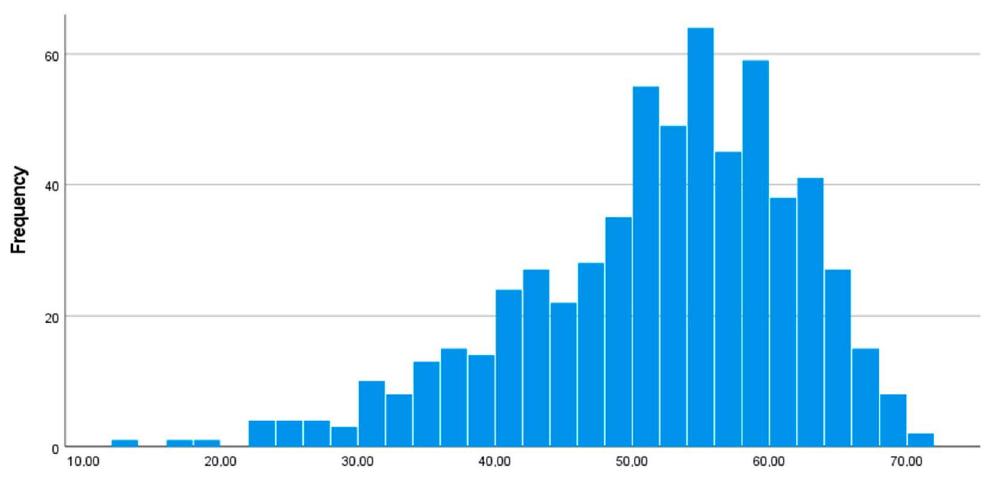
Figure 1. Job satisfaction (JSS ratings) in the sample.